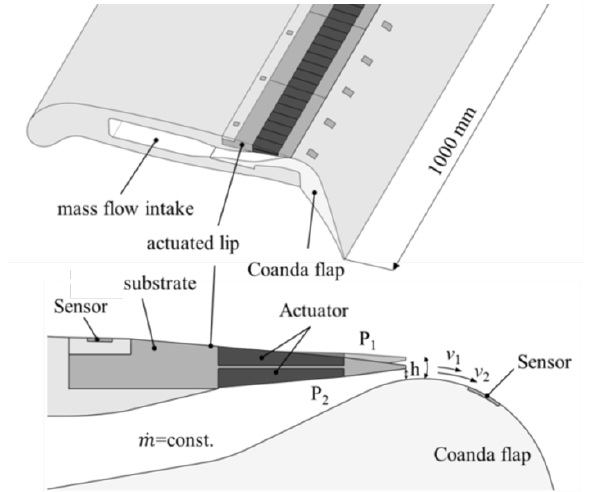
Figure 1. Concept of the blown Coanda flap with active flow control. Top: general view of the wing section; Bottom: detailed view of a generic bending transducer to control the blowing slot and functional principle of the active flow control system.